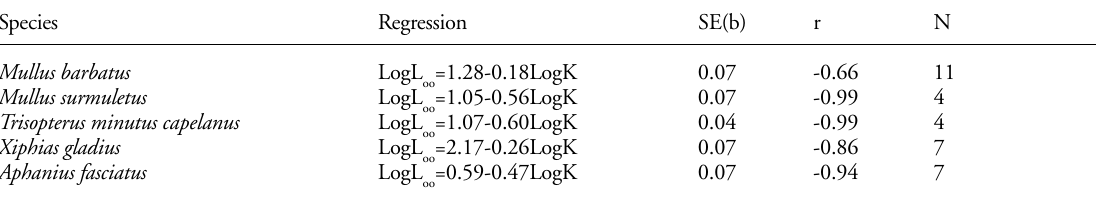
Table 2. Regression equations between the von Bertalanffy (1938) growth parameters K and L waters. SE(b) is the standard error of the slope, r is the correlation coefficient, and n is the number of stocks per species. For all regressions, P<0.05.